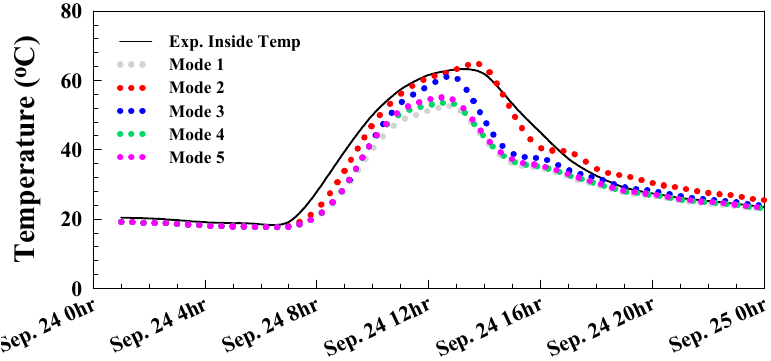
Figure 8. Variation in greenhouse internal temperature for different radiation models.